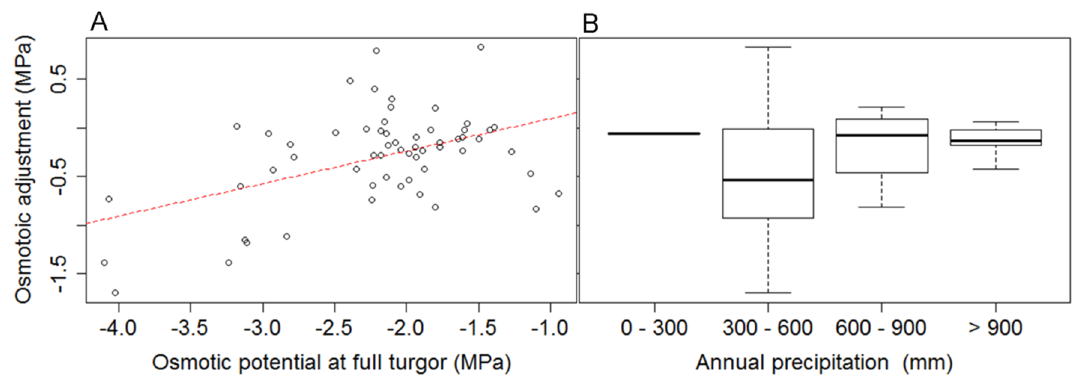
Figure 6. Relationship between osmotic adjustment and ( A ) osmotic potential at full turgor (under high water availability) and ( B ) mean annual precipitation. Data in ( A ) are fitted with linear regression (red dashed line; r 2 = 0.22, p <